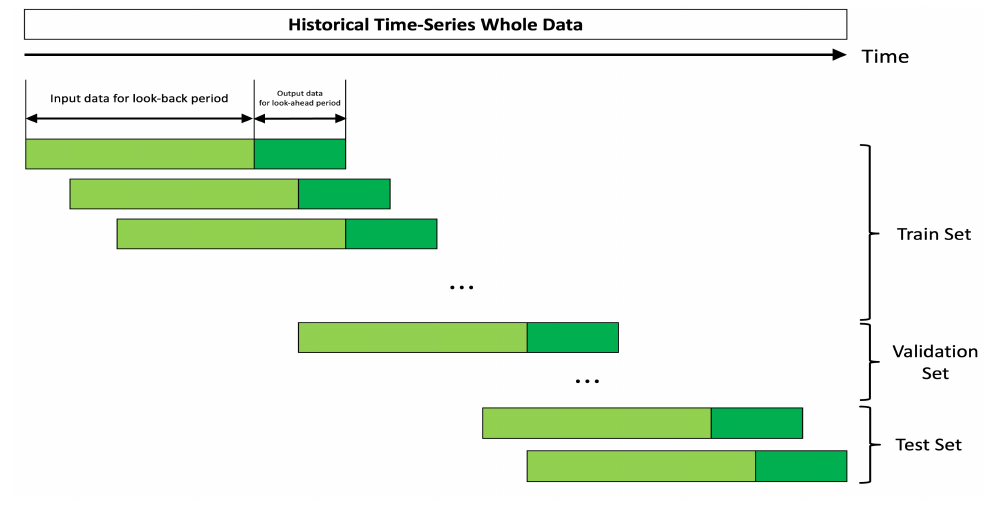
Figure 2. Sliding window